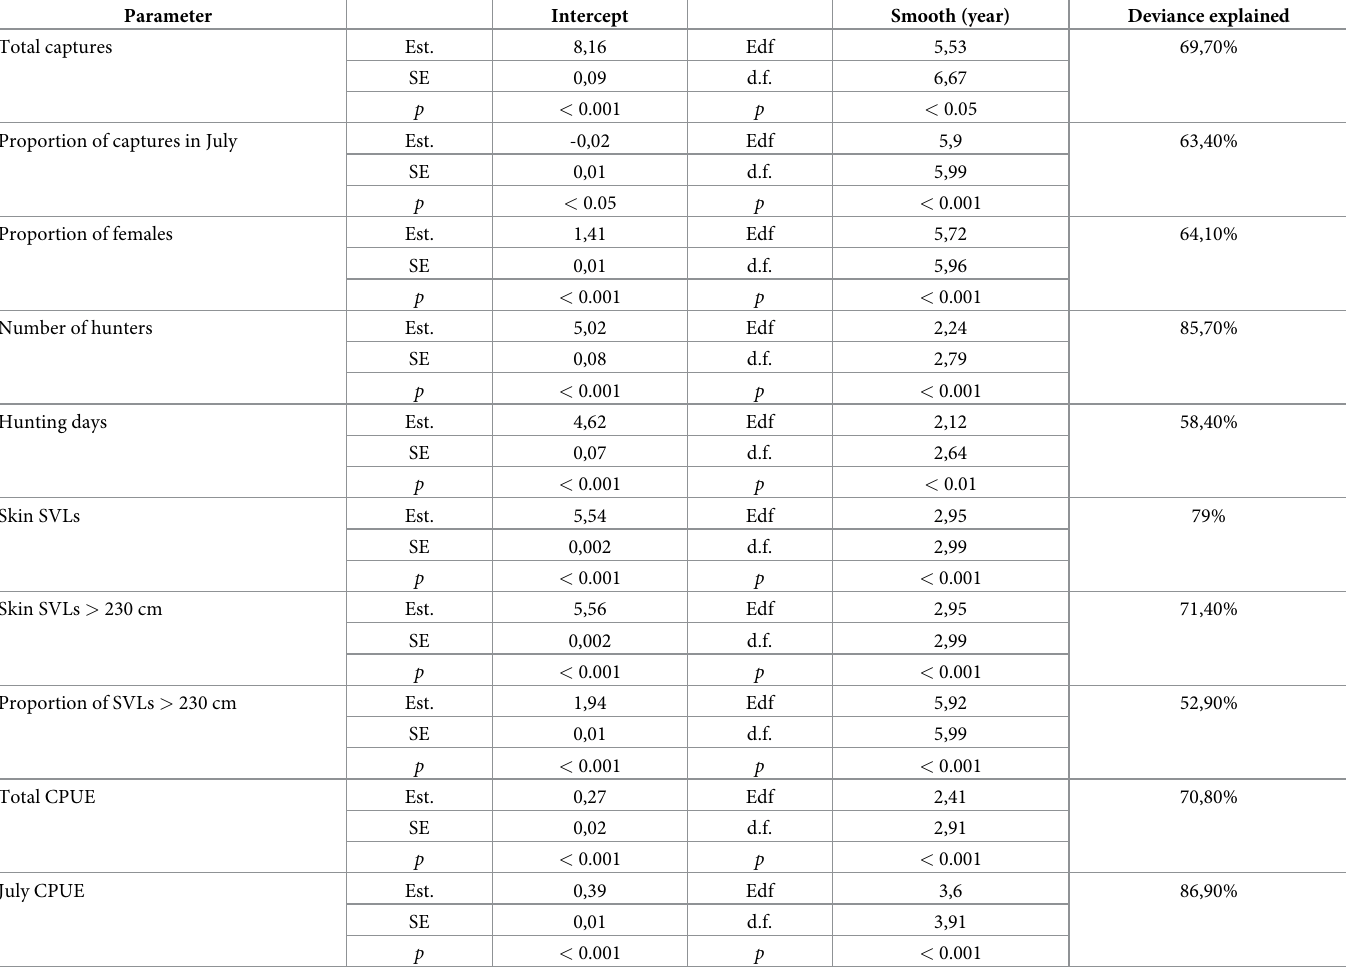
Table 2. Selected GAM-based models for the trends in yellow anaconda ( Eunectes notaeus ) harvest parameters measured by the Programa Curiyú between 2002– 2019 in northeastern Argentina.